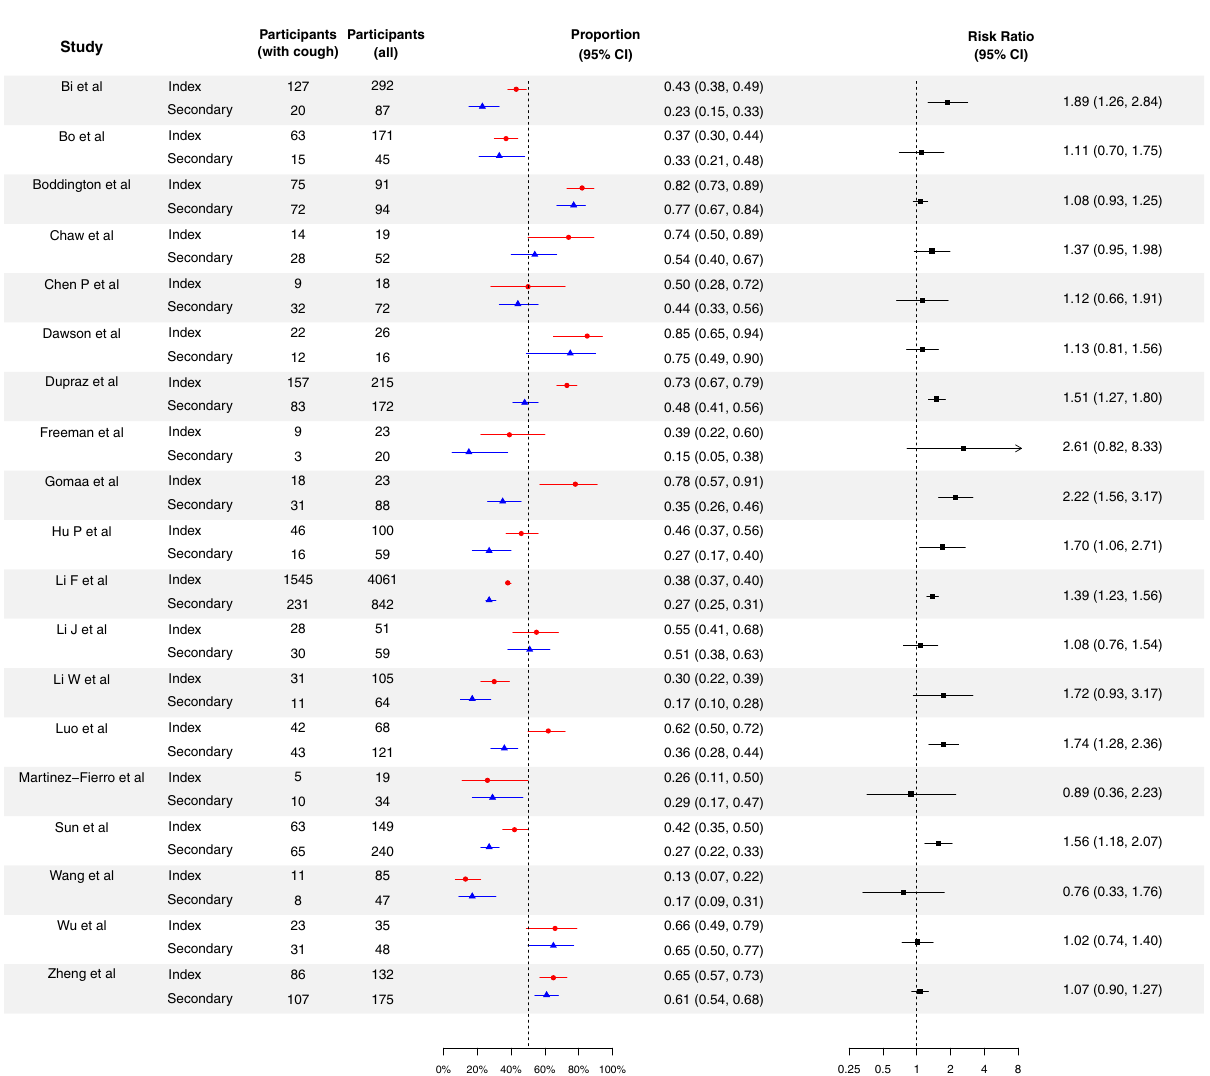
Fig. 2 Proportion of cases with cough for the index cases and secondary cases for COVID-19, and their corresponding risk ratio of index cases, compared with secondary cases. Red circles and lines indicate the proportion of fever of index cases and the corresponding 95% exact binomial con fi dence intervals. Blue triangles and lines indicate the proportion of fever of secondary cases and the corresponding 95% con fi dence intervals. Black squares and lines indicate the risk ratio of proportion of fever of index cases compared with secondary cases and the corresponding 95% con fi dence intervals calculated based on normal approximation. All statistical tests are two-sided tests. Adjustments are not made for multiple